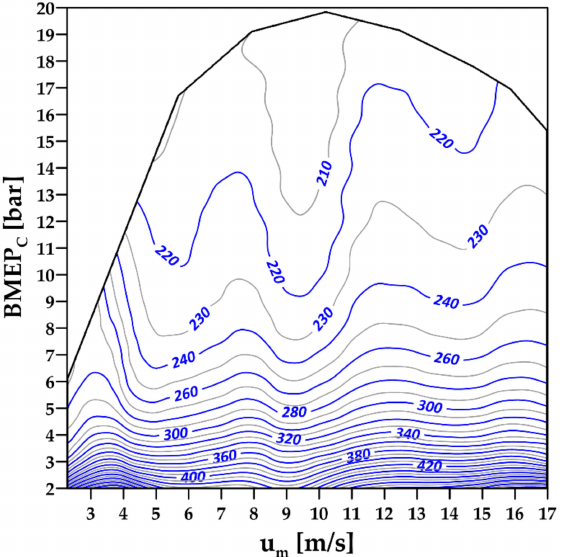
Figure 12. Brake specific fuel consumption map of the reference turbocharged engine with T 4 /T 1 =